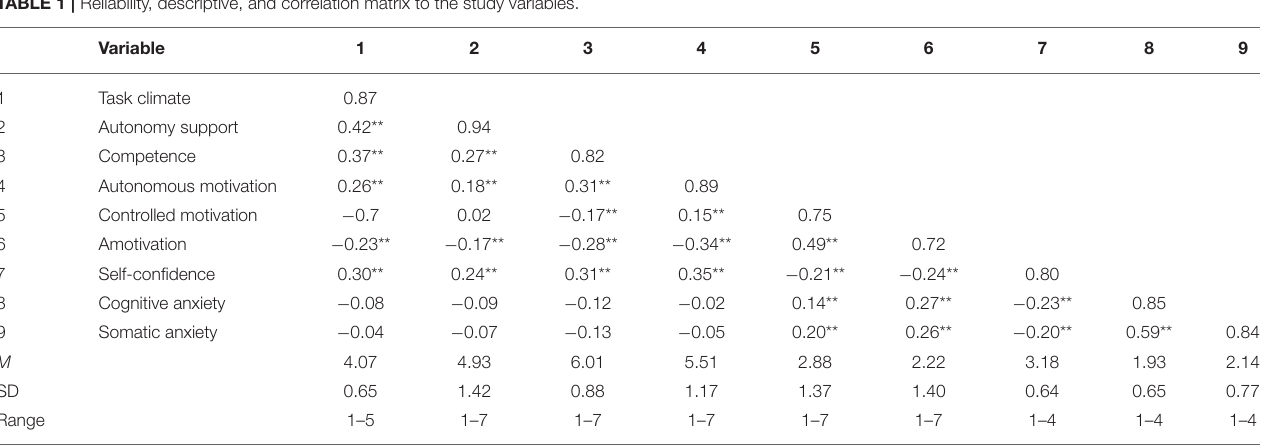
TABLE 1 | Reliability, descriptive, and correlation matrix to the study